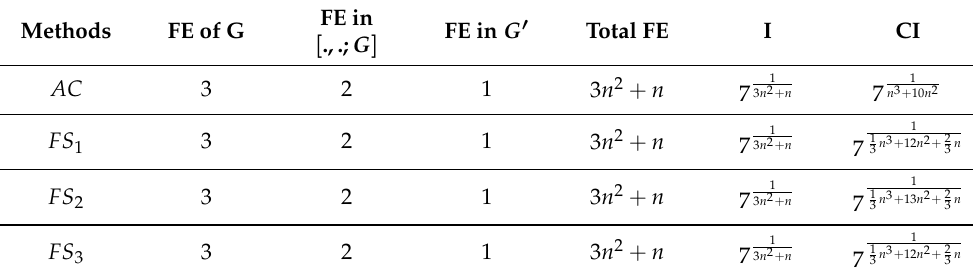
Table 2. Efficiency Index(I) and Computational Efficiency Index(CI).